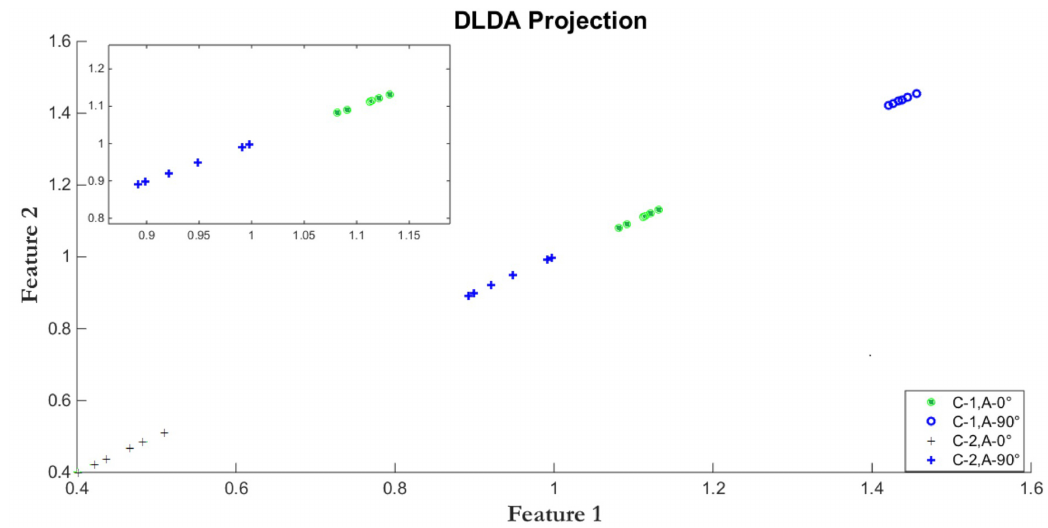
Figure 5. Linear Discriminant Analysis (LDA). The projection is more likely to group the samples according to the view angle rather than according to classes.